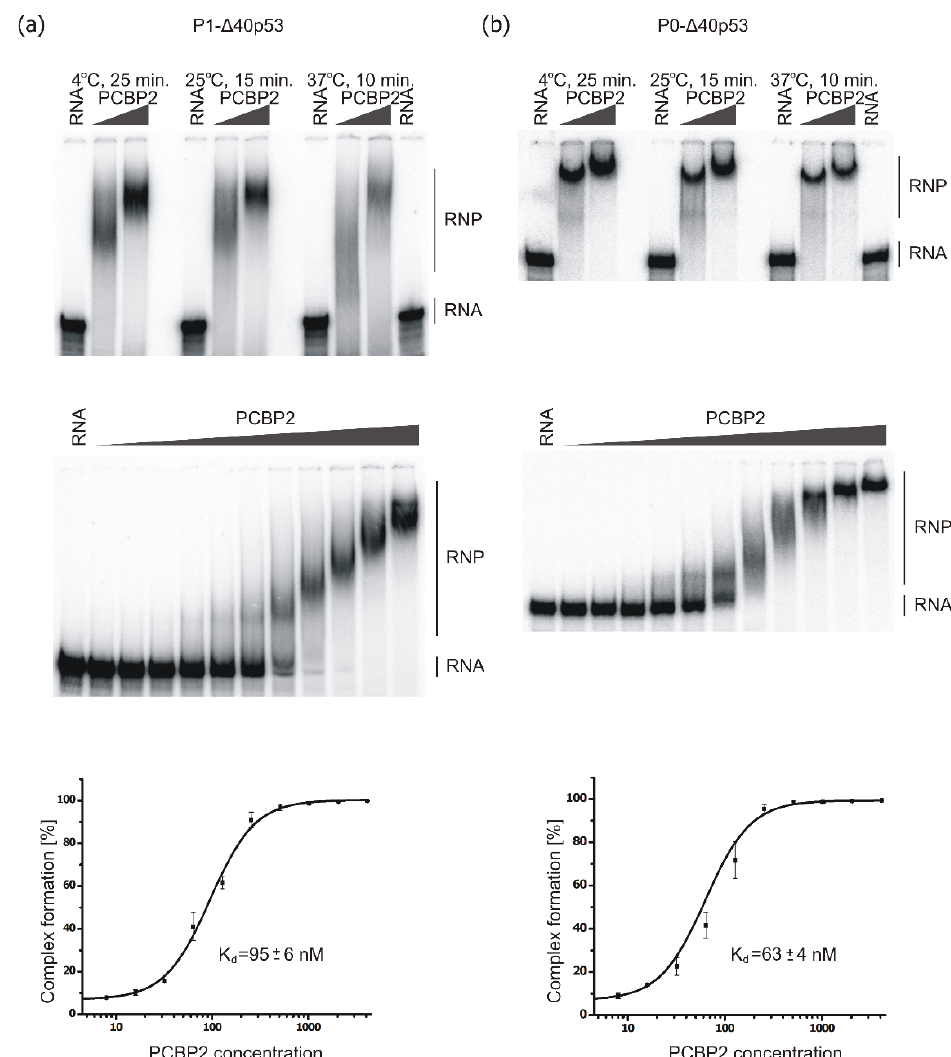
Figure 2. PCBP2 interacts directly with P1- Δ 40p53 RNA ( a ) and P0- Δ 40p53 RNA ( b ) in in vitro conditions. The EMSA assays were performed by incubation of [32P]-labelled RNAs with two final concentrations of purified PCBP2: 1000 nM and 2500 nM under three different conditions specified in the figure (top panel) and then with increased concentrations of PCBP2 3.9, 7.8, 15.6, 31.3, 62.5, 125, 250, 500, 1000, 2000 and 4000 nM at 4 °C for 25 minutes (middle panel). The samples were separated on native 4% polyacrylamide gels. The first lane in each EMSA panel represents the RNA oligomer incubated without the protein. Unbound RNAs and RNP complexes are indicated. Graphs representing dissociation constant (Kd) curves of PCBP2 binding to P1 Δ 40p53 and P0 Δ 40p53 RNAs, respectively, measured from three independent experiments are also shown (bottom panel).